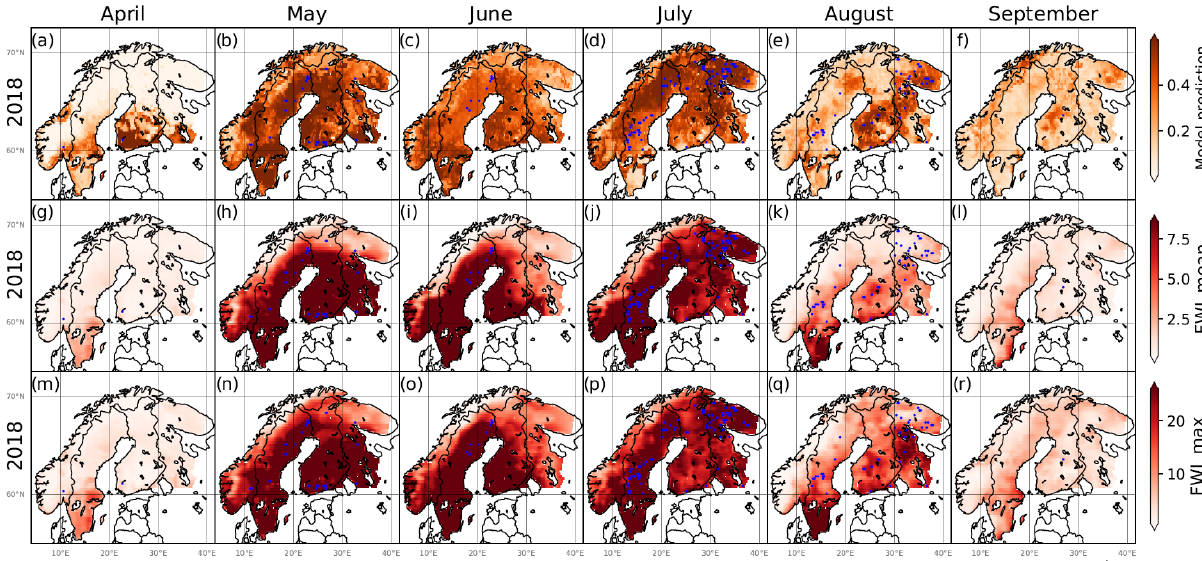
Figure 8. Fire danger probability maps for April–September 2018 using (a–f) the data-driven model predictions, (g–l) FWI_mean and (m– r) FWI_max. Blue markers show fire occurrences using the satellite-based fire occurrence dataset. Colour axes are truncated at the 5th and 95th percentile.